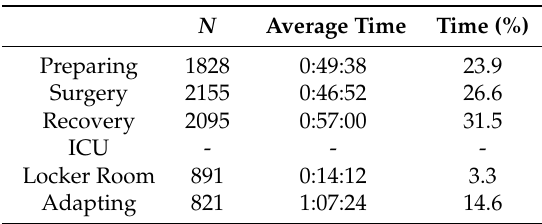
Table 4. Outpatients